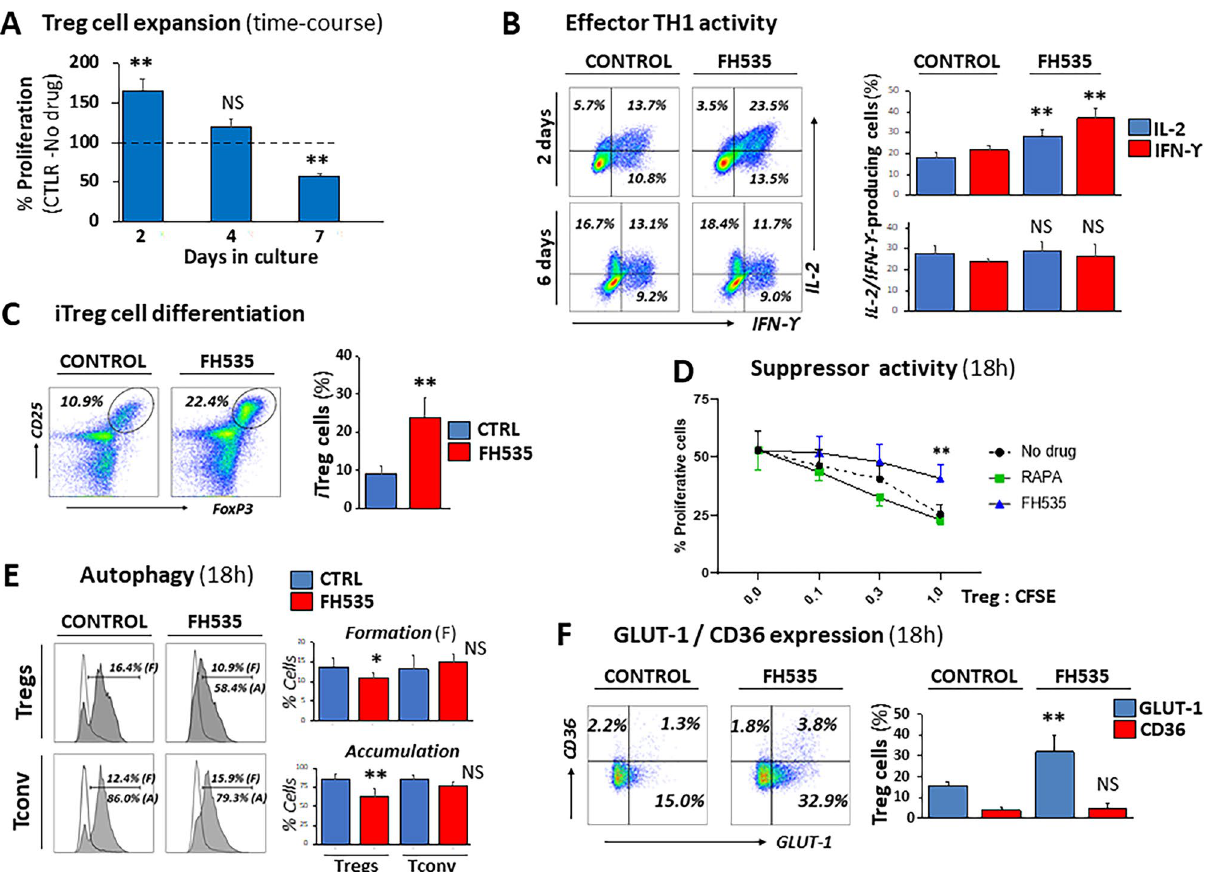
Figure 2. Immunomodulatory properties of FH535 on Treg and Teff cell responses. ( A ) Time-course of in vitro expansion of Treg cells. Pooled data from four independent experiments are depicted as mean ± SD percentages of FH535-exposed cells with respect to control (untreated) cells (dotted line, 100% reference value). ( B ) Representative plots and pooled data (mean ± SD) from four independent experiments of effector TH1 responses in conventional CD4 + T cells after 2- and 6-days culture in TH1-polarization media (see “Methods” section) with or without addition of FH535. Plot windows include the corresponding percentages of intracellular IL2- and IFNg-producing cells. ( C ) Representative plots and pooled data (mean ± SD) of four experiments of in vitro induced Treg cells (FoxP3 + /CD25 + , iTregs) after seven day-culture of conventional CD4 + T cells in Treg-polarizing conditions in the absence (Control) or presence of FH535. ( D ) Loss of suppressor activity in peripheral Treg cells after 18 h-exposure to FH535. Results show the mean ± SD from three independent experiments. ( E ) Analysis of intracellular autophagic vacuoles in Treg (top) and Tconv (bottom) cells cultured for 18-h without (Control) and with FH535. Representative histograms and pooled data (mean ± SD) from three independent experiments of CytoID expression in cells cultured alone (empty histogram) illustrate the autophagic vesicle formation (F) overlaid with the corresponding samples co-cultured with Chloroquine (filled grey) to measure autophagic vesicle accumulation ( A ). Results are expressed as percentages of positive cells. ( F ) Representative dual dot-plot analysis and pooled data (mean ± SD) of four independent experiments corresponding to the expression of GLUT-1 and CD36 in peripheral Tregs in response to FH535. Corresponding results with conventional T cells (Tconv) are shown in Fig. S4. Percentages of positive cells for each condition are indicated in each panel. Statistical differences promoted by FH535 treatment are shown as *( p < 0.05) and **( p < 0.005) compared with control (no drug) as assessed by Student’s t